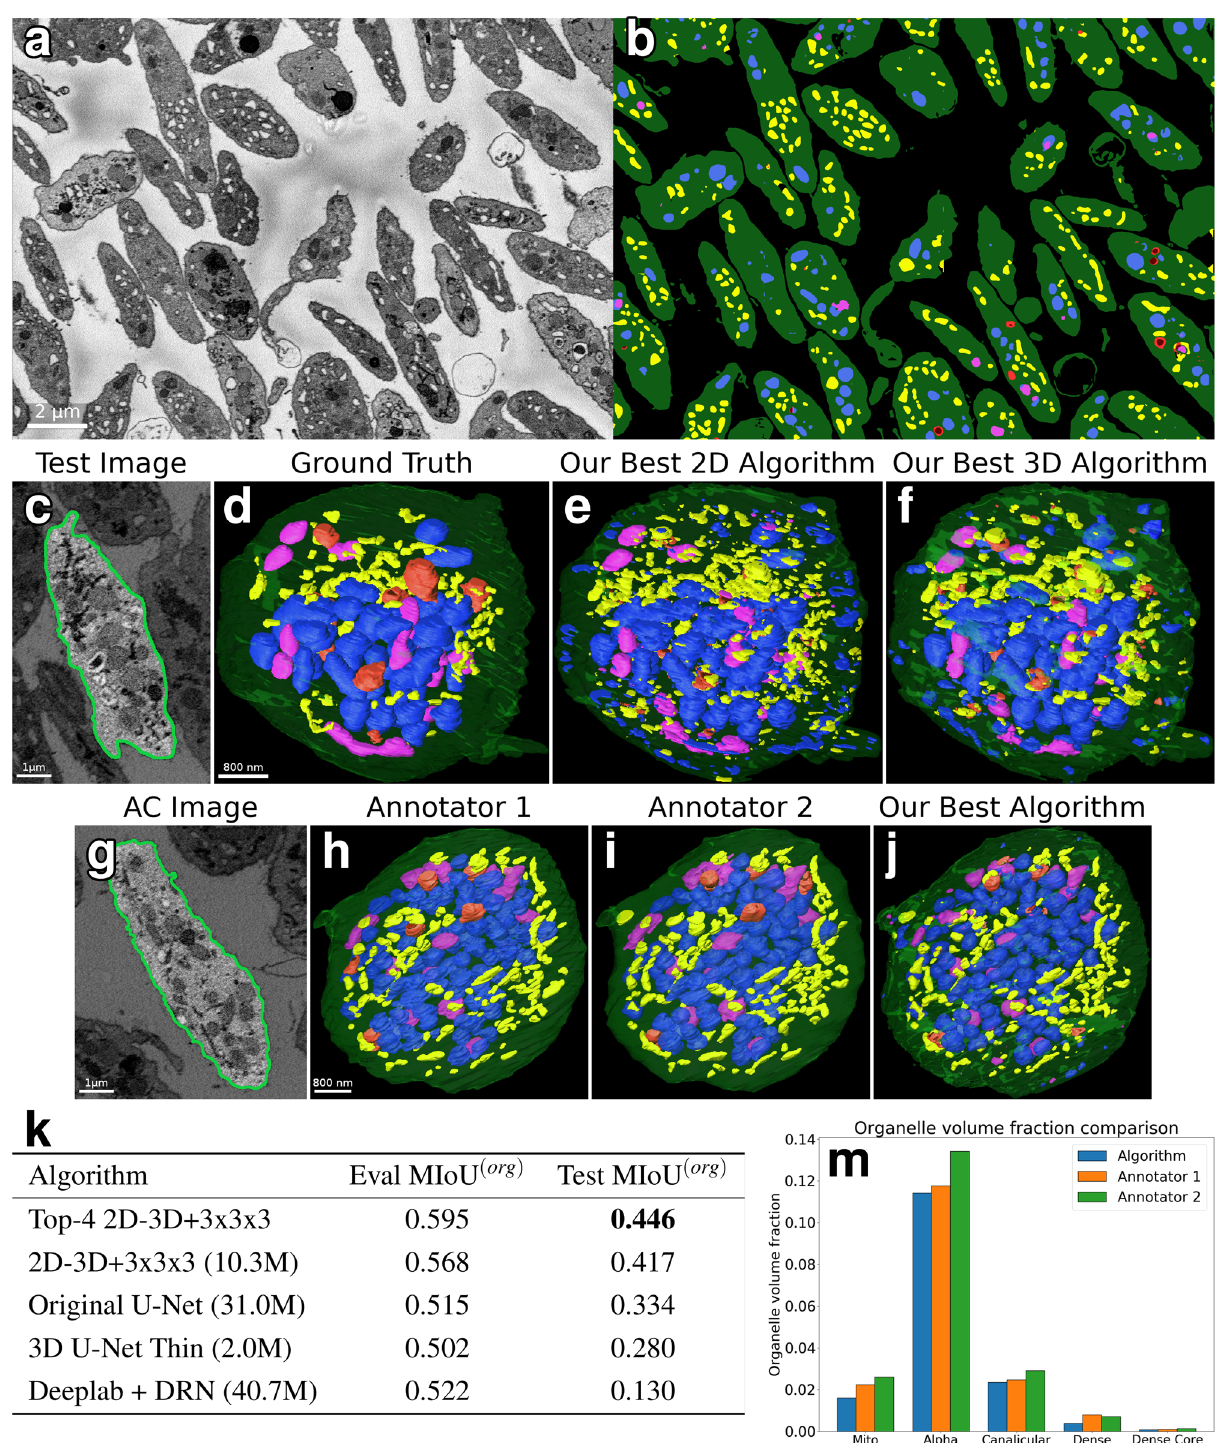
Figure 3. Results. ( a , b ) Orthoslice of Subject 1 image and segmentation. ( c ) Test dataset orthoslice, segmented cell highlighted. ( d , f ) Comparison between ground truth segmentation of test cell and our best 2D and 3D algorithms. ( g ) Annotator comparison (AC) dataset orthoslice, segmented cell highlighted. ( h , j ) Annotator comparison cell segmentations, comparing the two human annotators and our best (3D) algorithm. ( k ) Summarized comparison of mean intersection-over-union across organelle classes ( MIoU ( org ) ) on test and evaluation datasets for segmentation algorithms. For full results, see Table S1. ( m ) Comparison of organelle volume fractions between two human annotators and our best algorithm, computed from annotator comparison cell